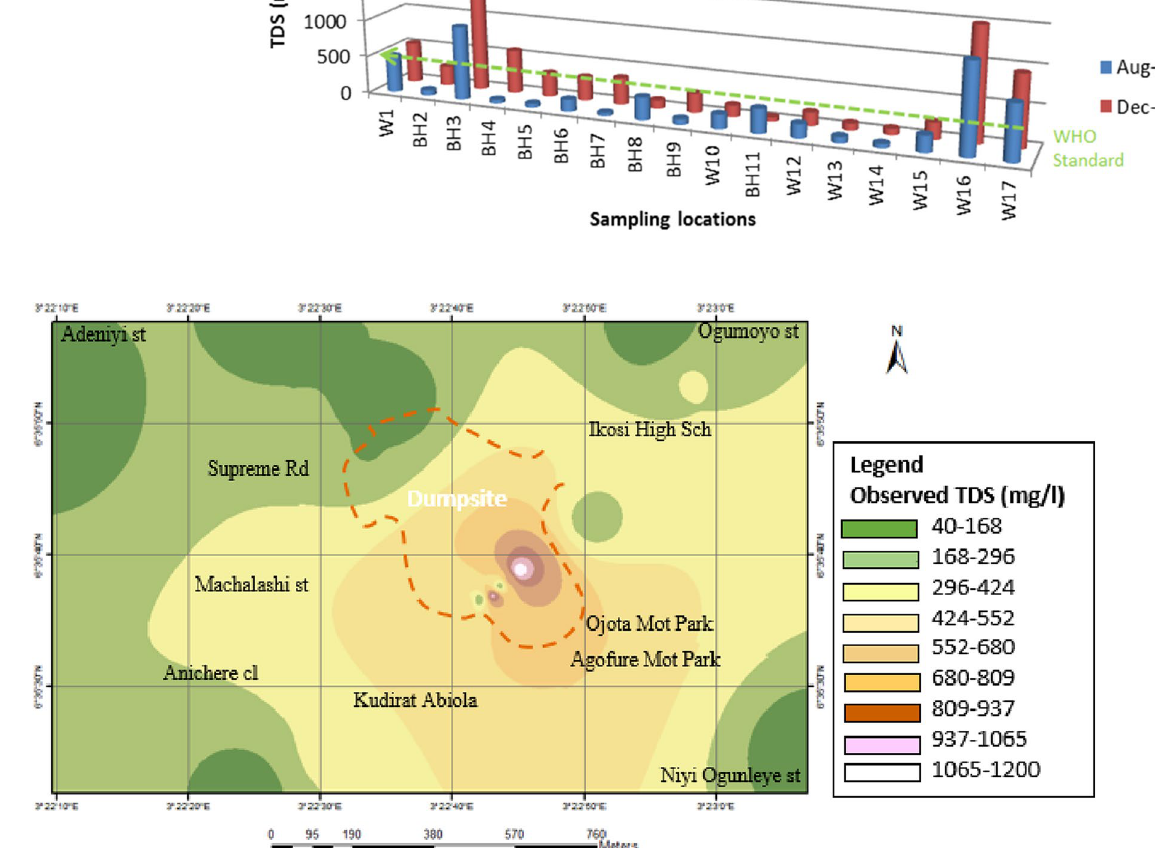
Fig. 8 Spatial distribution of total dissolved solid within the study area